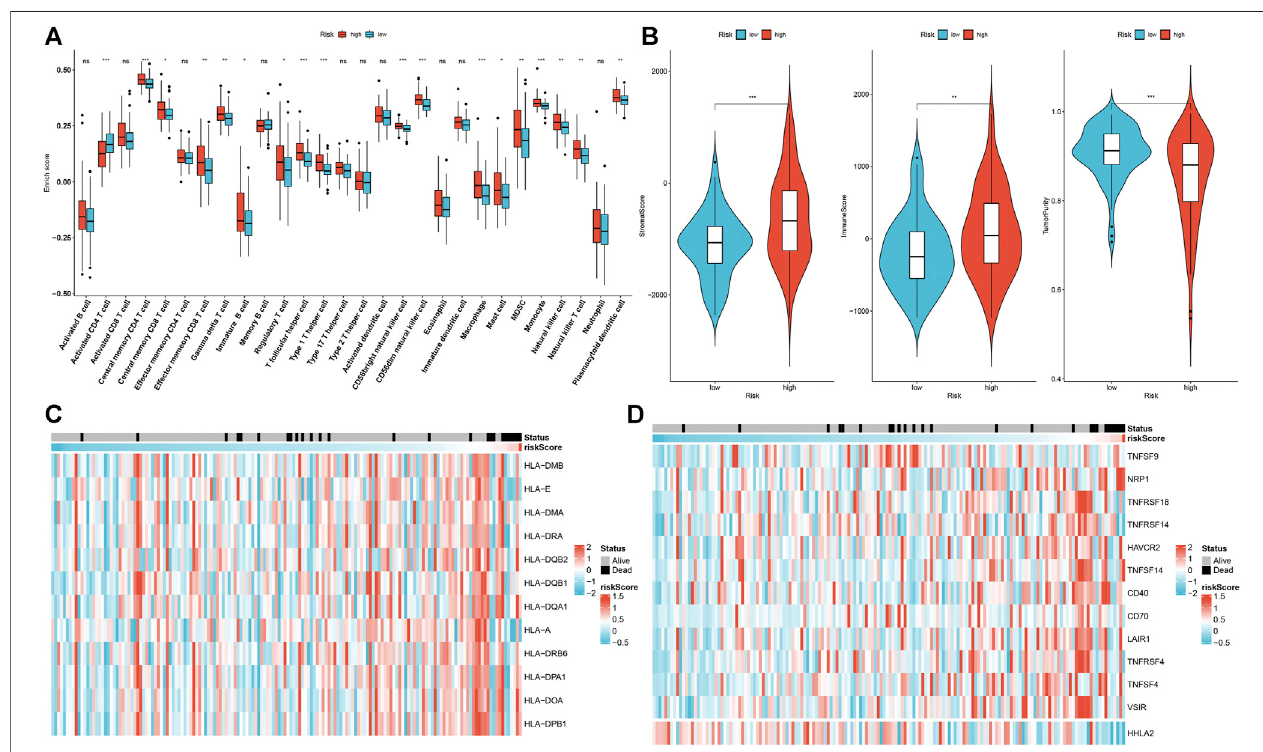
FIGURE 4 | Association of aging-related gene signature with the tumor immune microenvironment of rectal cancer in the discovery set. (A) Comparison of the abundance of tumor-in fi ltrating lymphocytes in high- and low-risk subgroups. (B) Comparison of stromal score, immune score, and tumor purity in high- and low-risk subgroups. (C) Distribution ofHLAgeneexpression inhigh-andlow-riskspecimens. (D) Distributionofimmunecheckpointexpression inhigh-andlow-riskspecimens. Ns: not signi fi cant; * p < .05; ** p < .01; *** p <